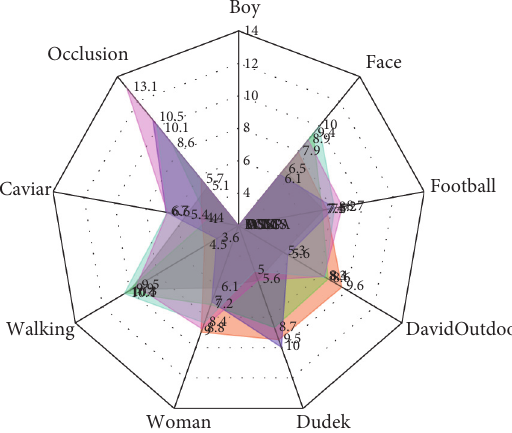
Figure 4: Average centre deviation